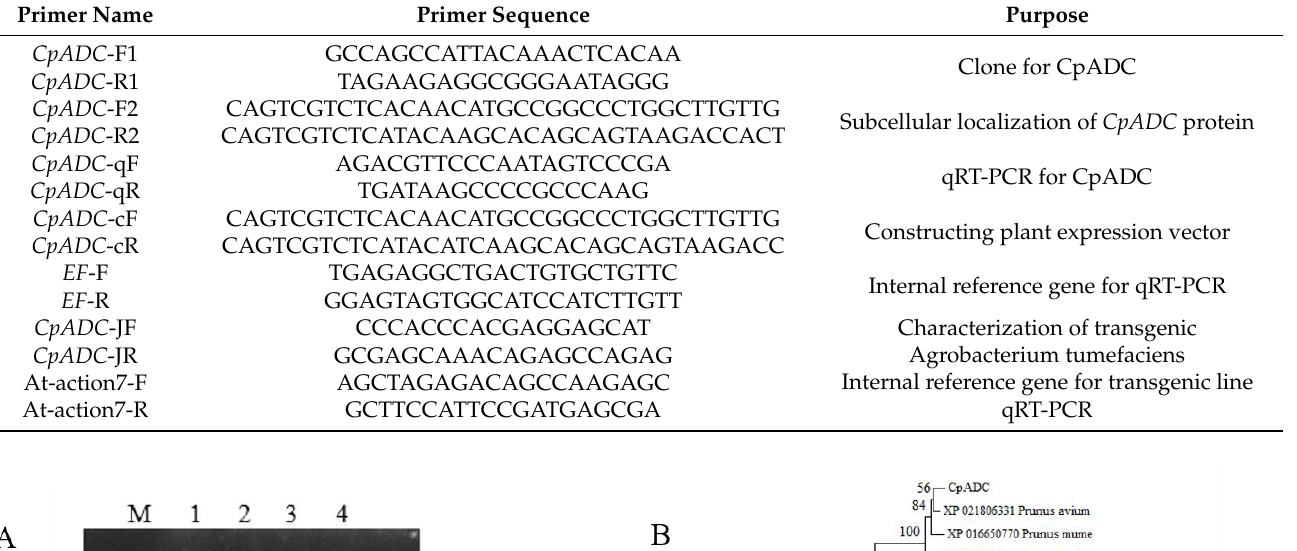
Table 1. The sequences of primers used for CpAD C cloning, its expression quantification and so on.